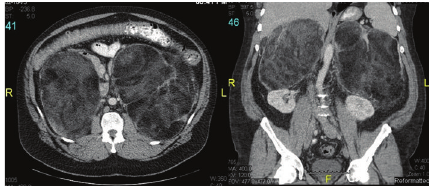
Figure 2: Gross pathologic specimen of the bilateral adrenal masses was described by the pathologist as left adrenal gland myelolipoma weighing 4116g and measuring 30 × 25 × 20 cm, and right adrenal gland myelolipoma weighing 2672 g and measuring 25 × 20 × 13 cm, both exhibiting hemorrhage, hemosiderin deposition, fibrosis, and fat necrosis, but no sign of